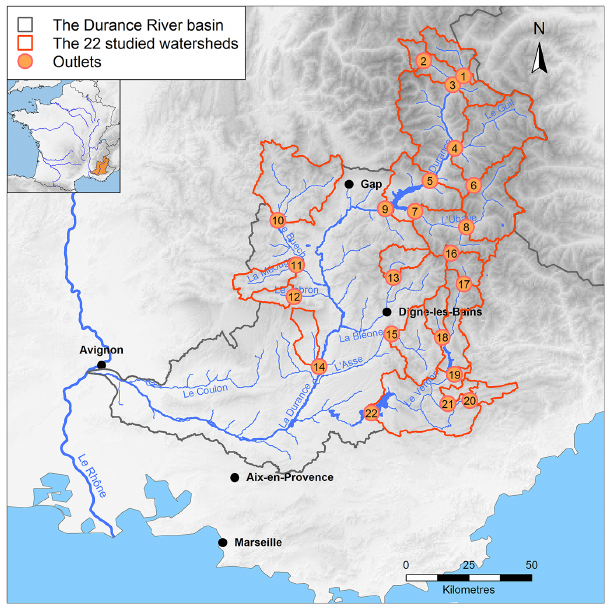
Figure 2. Map of the study area with the 22 selected